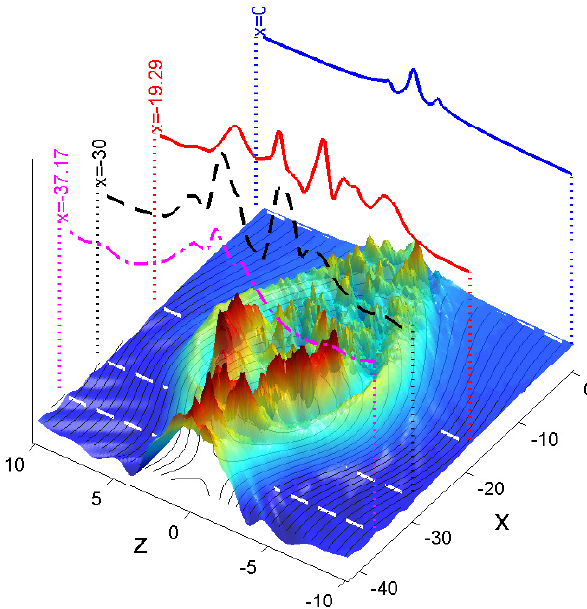
Fig. 1. The current density J y (coloured surface) and magnetic field lines in the x-z plane. The cuts of J y along the white dashed lines on the J y -surface are also